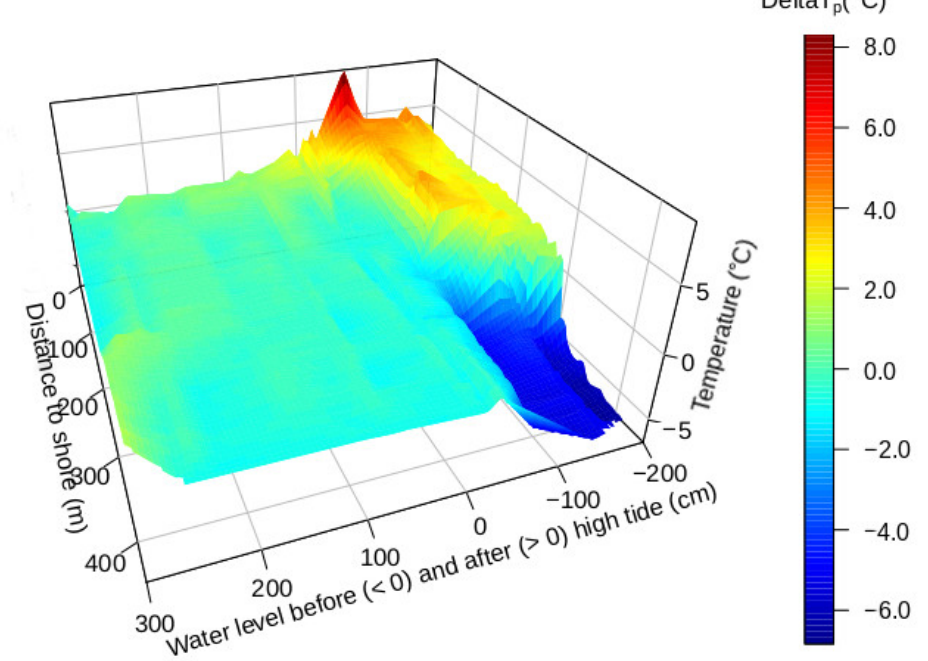
Figure 15. Longitudinal profiles of temperature difference to the profile mean temperature ( DeltaT p ) from both days across the intertidal mudflats and the tidal channel from hexacopter and gyrocopter datasets, arranged according to water